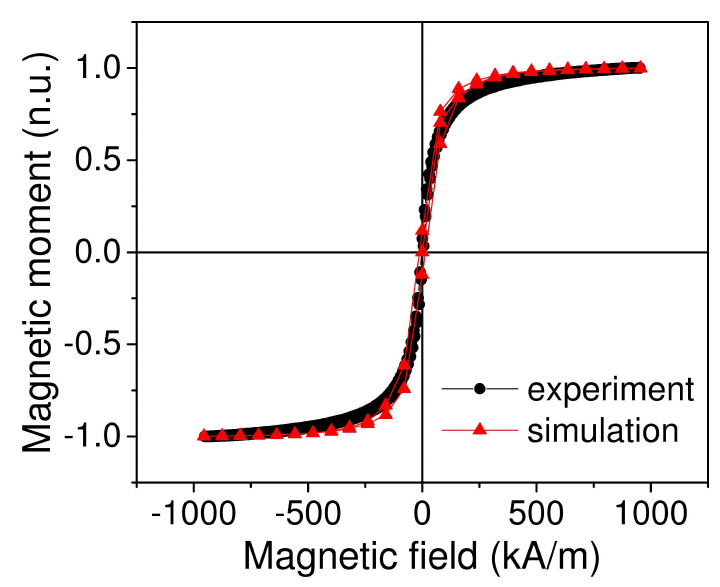
Figure 8. The comparison of experimental and simulated magnetization of MRE vs. applied magnetic field. Experiment was performed for the MRE sample with 8.1% volume concentration of Fe. Simulation was performed for the sample with 8.1% volume concentration of Fe, lognormal size distribution.